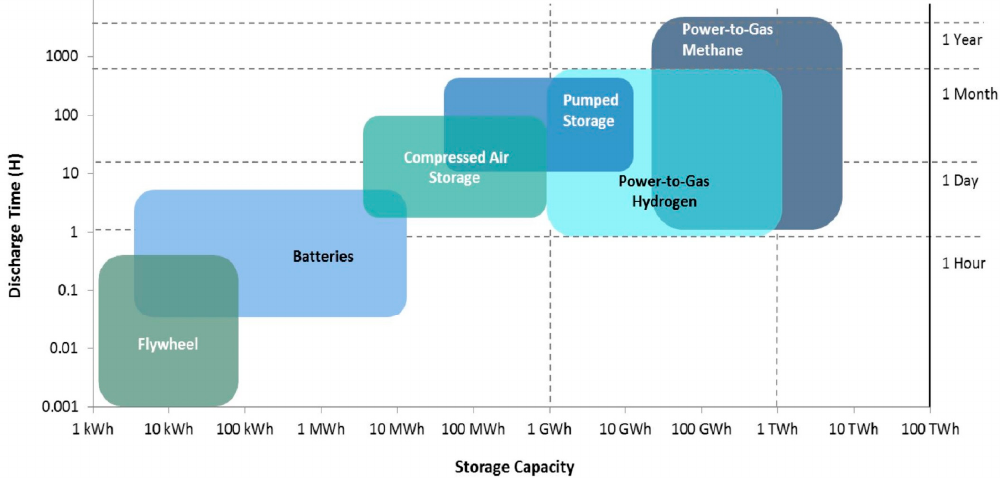
Figure 3. Comparison of discharge time vs capacity of energy storage technologies [24].